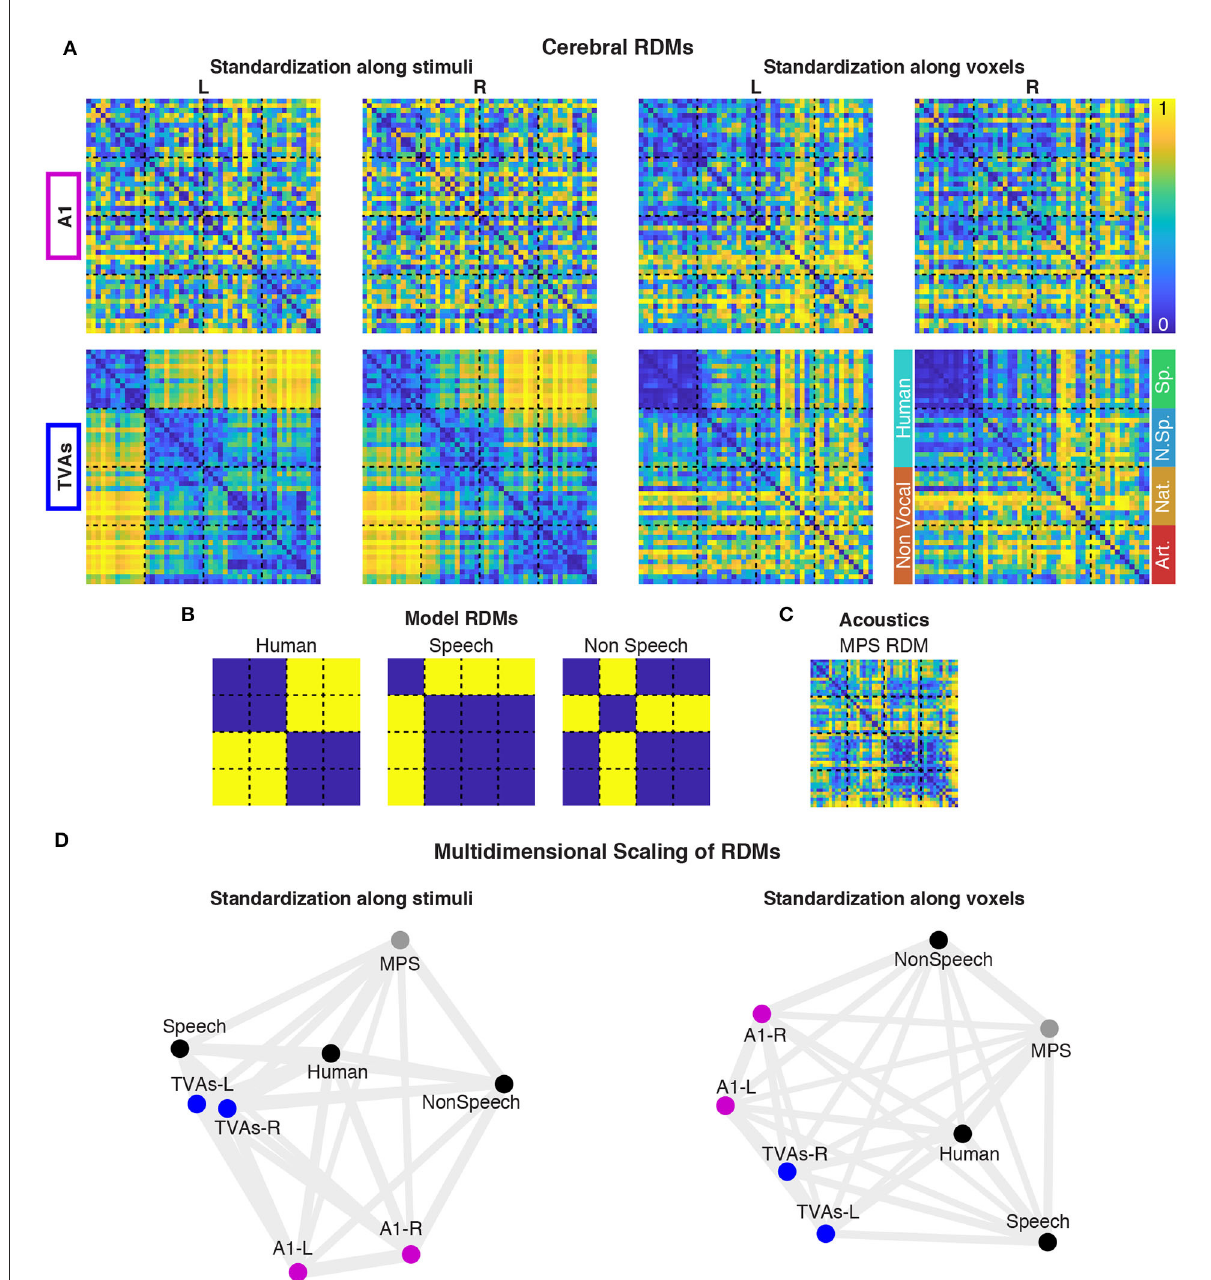
FIGURE2 Representational similarity analysis (RSA) in A1 and the TVAs. Cerebral RDMs showing percentile dissimilarities in pairwise fMRI response to the 48 stimuli, for both ROIs and standardization methods (A) . Portions of the RDMs corresponding to the main and sub-categories of stimuli are indicated next to the bottom right RDM. Cerebral RDMs were compared (Spearman correlations) with three categorical model RDMs (B) and one acoustical RDM (C) , for each standardization method. These comparisons are represented via multidimensional scaling (D) .